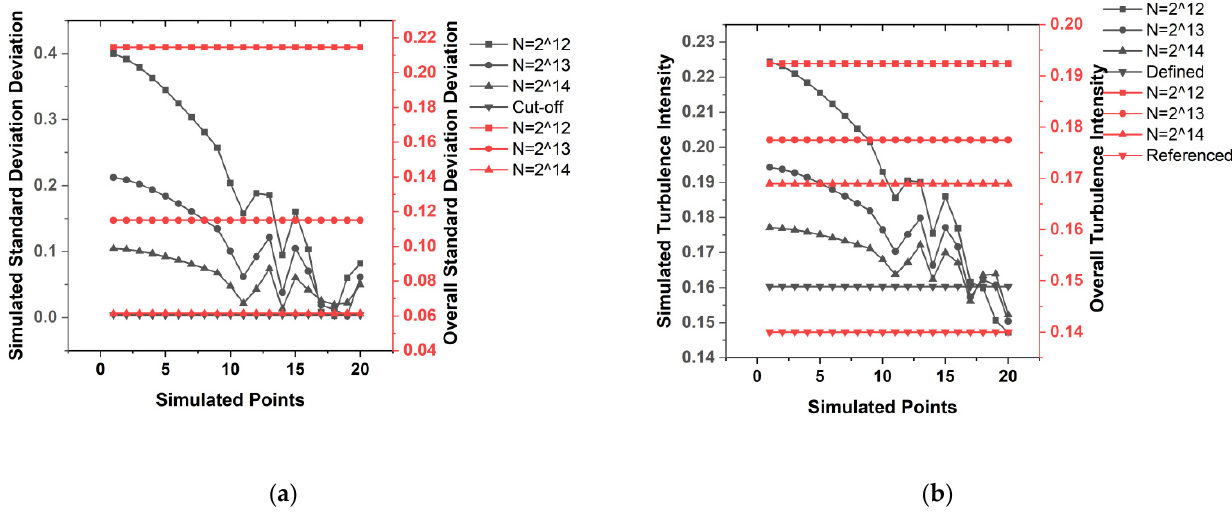
Figure 2. ( a ) The deviation of standard deviation at a different frequency sampling magnitude; ( b ) Simulated turbulence intensity at a different frequency sampling magnitude. Table 1. The relationship between the frequency sampling points scale and simulated deviation. Test No. Test 1 Test 2 Test 3 Test